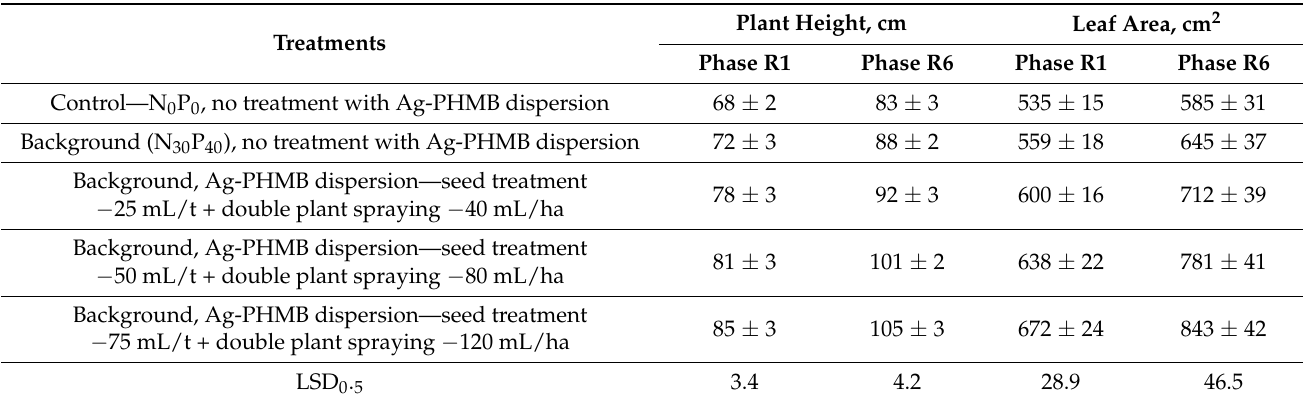
Table 3. Effect of the treatment with aqueous dispersion of Ag-PHMB on the morphological parame- ters of soybean plants (Vilana cultivar) during the R1 and R6 phases (average data for 2019–2020), confidence probability, p =